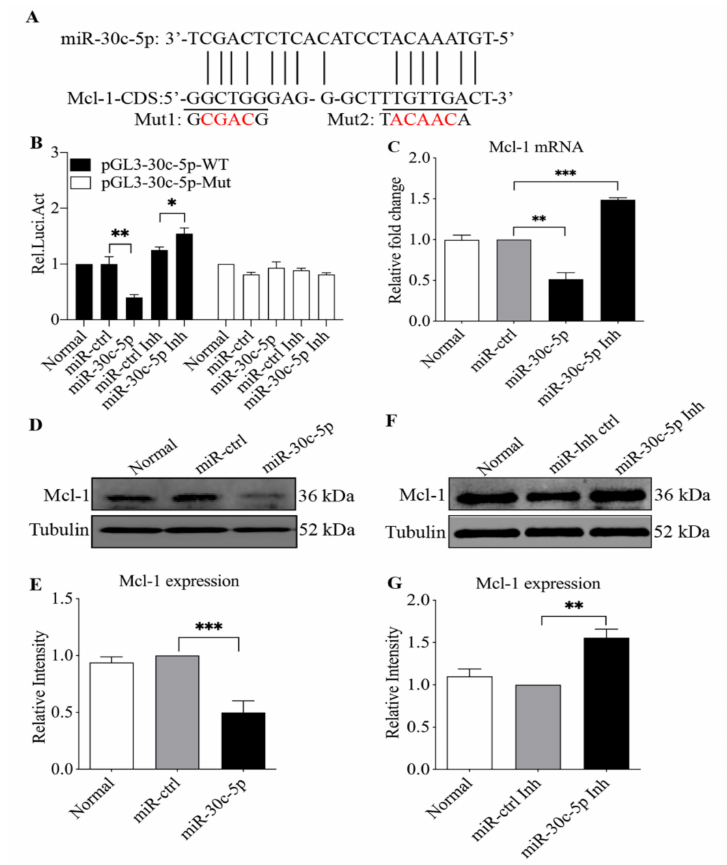
Figure 5. The Mcl-1 gene is a cellular target of gga-miR-30c-5p. ( A ) Diagram of the predicted target site for gga-miR-30c-5p in Mcl-1 gene. The target sequences of gga-miR-30c-5p are underlined and were mutated as indicated. ( B ) The transfection of LMH cells with gga-miR-30c-5p reduced the expression of Mcl-1 but not its mutant. The LMH cells were co-transfected with gga-miR-30c-5p mimics (80 nM), inhibitors (Inh) (200 nM), or miRNA controls, together with luciferase reporter gene vectors (200 ng) and pRL-TK (20 ng). Forty-eight hours post-transfection, the cells were lysed,